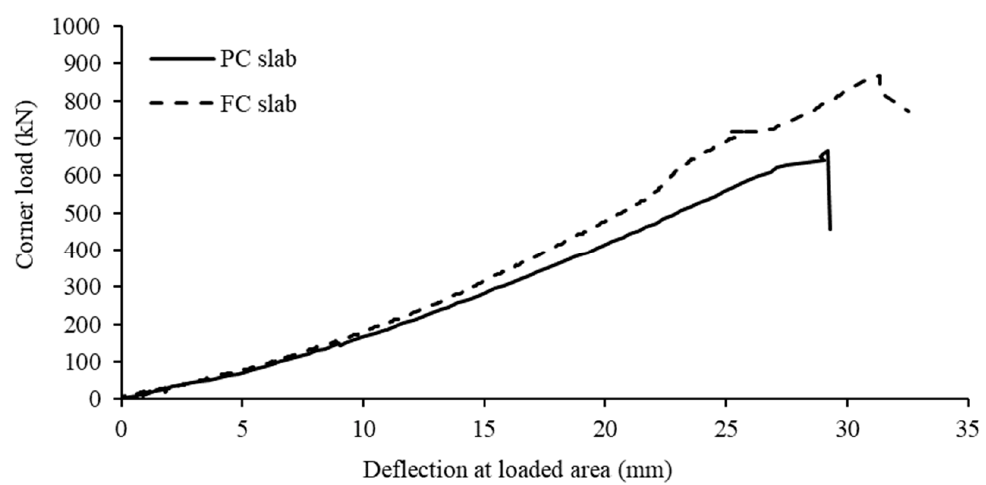
Figure 14. Corner load versus deflection at the loaded area of PCC and MSFRC slabs. The interior applied load versus deflection curves of PCC and MSFRC slabs, which were tested by applying a load at the interior of the slabs, labelled as slabs PI and FI, load of slab PI was 735 kN. Meanwhile for slab FI, the ultimate load was 971 kN. This PI. In addition, this achieved an increase in the ductility of slab FI by about 43% more than slab PI. The recorded deflection that occurred for slab PI was 13.1 mm. Meanwhile for slab FI, the maximum deflection was 16.7